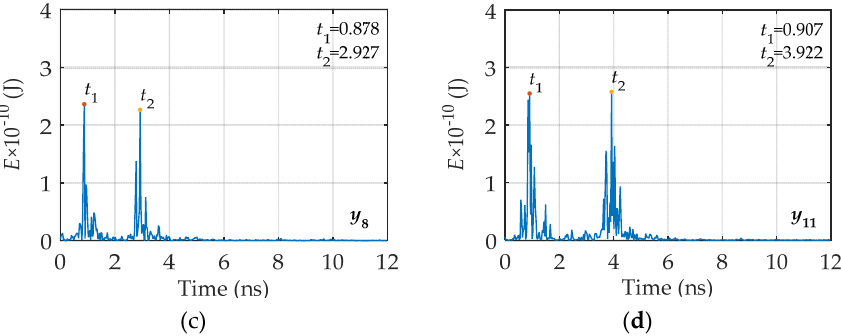
Figure 14. TEDAWT curves of single-channel signals on the horizontal survey lines: ( a ) survey line y 2 ; ( b ) survey line y 5 ; ( c ) survey line y 8 ; ( d ) survey line y 11 .